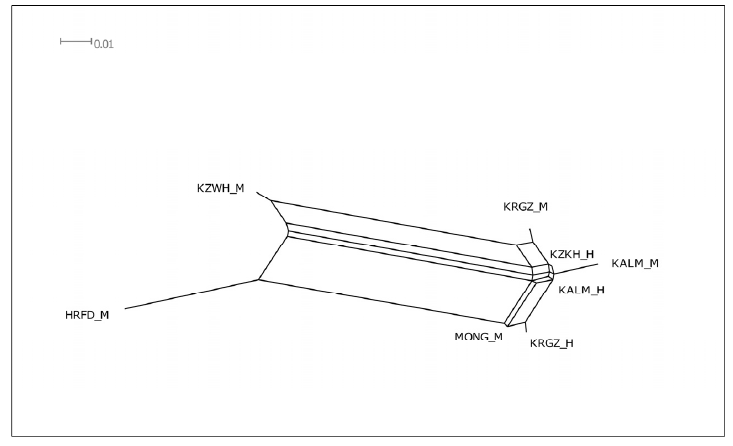
Figure 3. Neighbor-Net graphs based on Jost’s D genetic distances characterizing genetic relation- ships between studied museum and modern cattle populations. Museum populations: KALM_H—